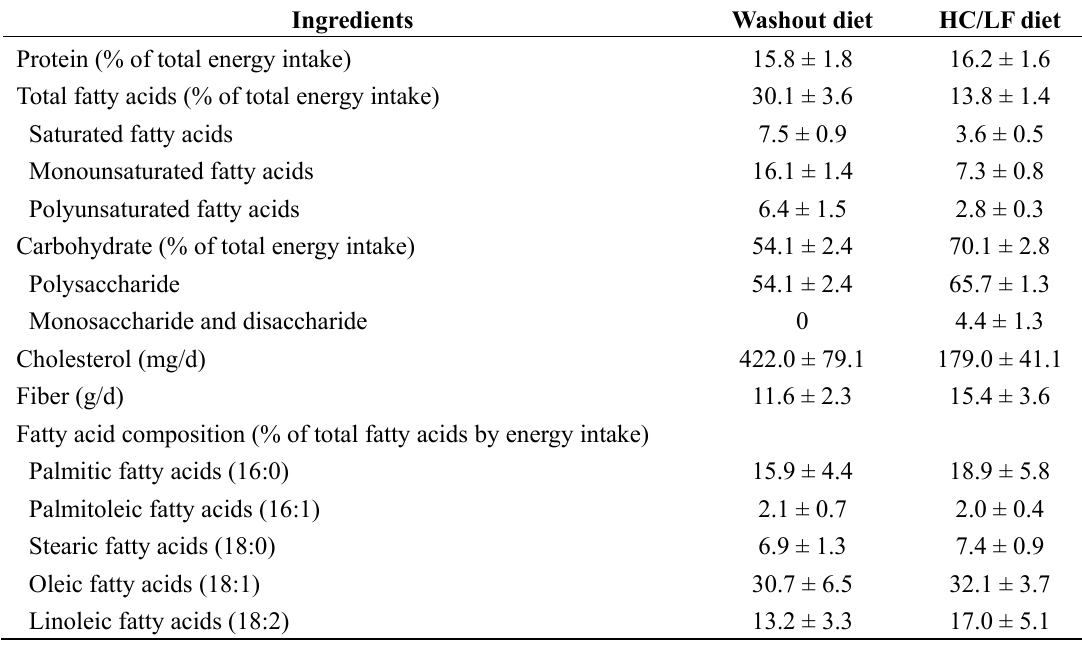
Table 1. Composition of the washout diet and the HC/LF